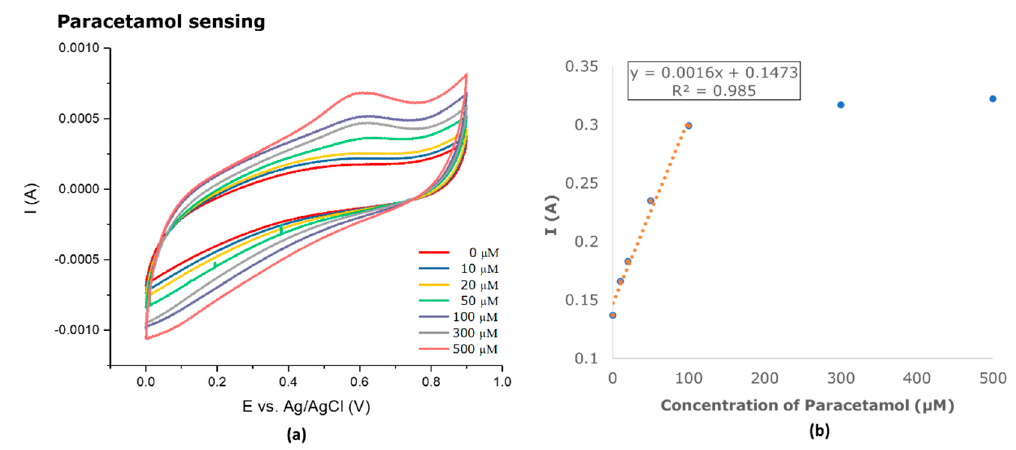
Figure 5. ( a ) PPy.SDS on CF sensing various concentration of paracetamol in 0.1 M PBS solution at a scan rate of 50 mVs − 1 ; ( b ) calibration curve for PPy.SDS on CF with a concentration range of 0–500 µM paracetamol in 0.1 M PBS